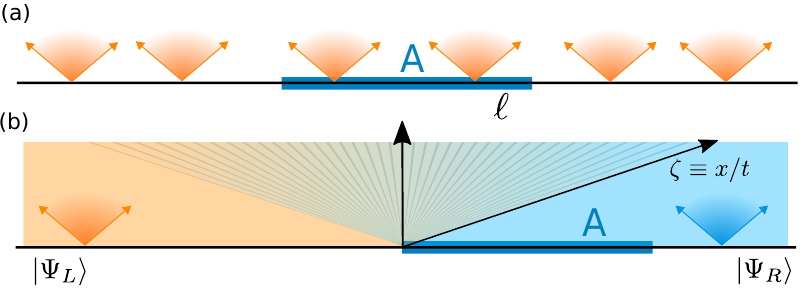
Figure 1: Dynamics of the entanglement entropy after a quench from a homogeneous (in (a)) and a piecewise homogeneous initial condition (in (b)). In both cases the entanglement dynamics is due to the ballistic propagation of pairs of entangled parti- cles (shaded cones). In (a) the quasiparticles entanglement entropy is the thermody- namic entropy of the GGE that describes the steady state. In (b) the inhomogeneous initial state is obtained by joining two homogeneous systems (left and right) in the 〉 and | Ψ 〉 . Entangled pairs are produced in the bulk of the two chains. states | Ψ L R A lightcone spreads from the interface between them. For each value of ζ ≡ x / t the system relaxes locally to a GGE. The entanglement entropy is obtained propagat- ing the entropy of the GGEs describing the bulk of the left and right chains, i.e., for ζ → ±∞